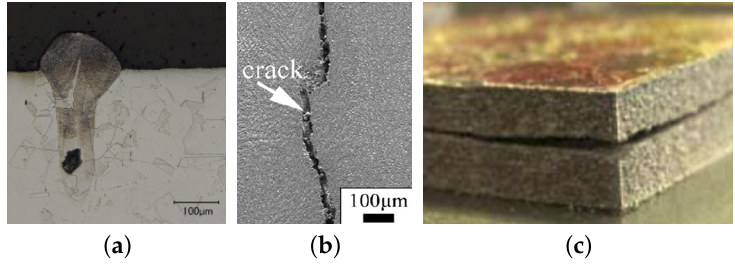
Figure 5. AM defects: ( a ) keyhole induced porosity; ( b ) cracks; and ( c ) delamination